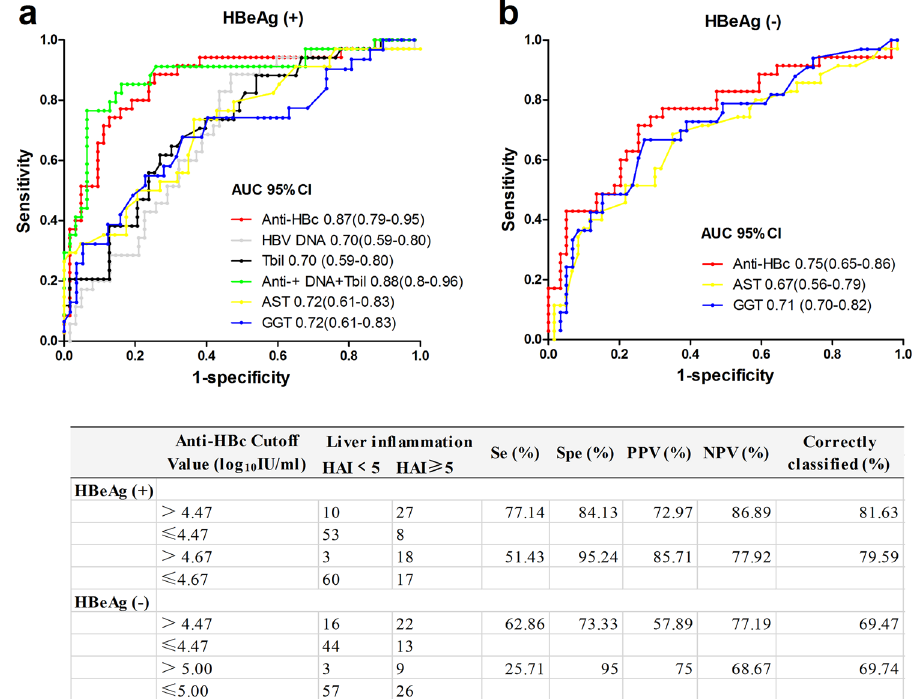
Figure 4. Serum anti-HBc holds a better diagnostic value for differentiating between mild or no (HAI < 5) and moderate-to-severe (HAI ≥ 5) in HBeAg ( + ) ( a ) and HBeAg ( − ) ( b ) patents with normal ALT. AUROC, area under receiver operating characteristics curve; GGT, gamma glutamyl transpeptidase; AST, aspartate aminotransferase; Se, sensitivity; Spe, specificity; PPV, positive predictive value; NPV, negative predictive